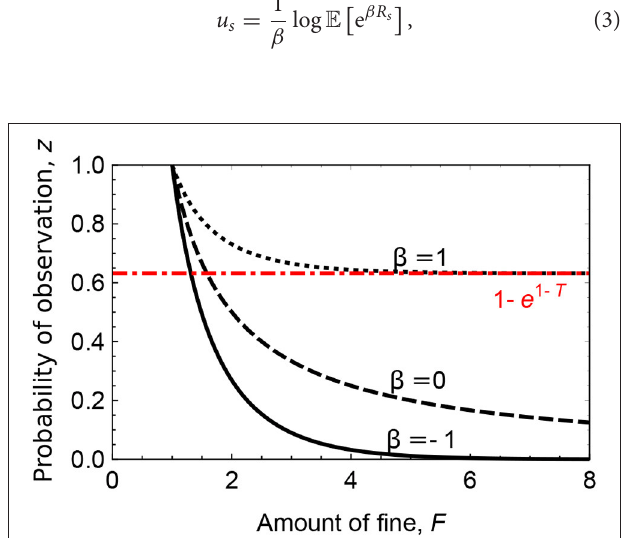
FIGURE 1 | The infimum of the required probability of observation by an authority to maintain cooperation: individuals are risk newtral (dashed line; z ∗ neutral where β = 0), risk averse (solid line; z ∗ biased with β = − 1), or risk prone (dotted line; z ∗ biased with β = 1). The red dot-dashed line represents the asymptotic line to which z ∗ biased with β = 1 converges. Parameters: T = 2.